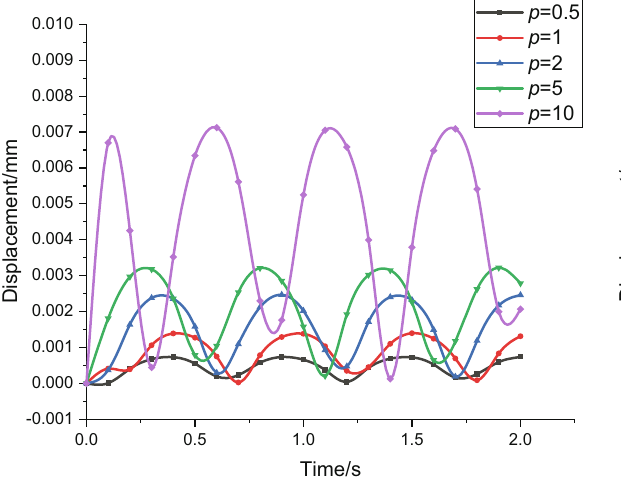
Figure 6: Overall displacement changes with time under di ff erent gradient parameters at z = 0.